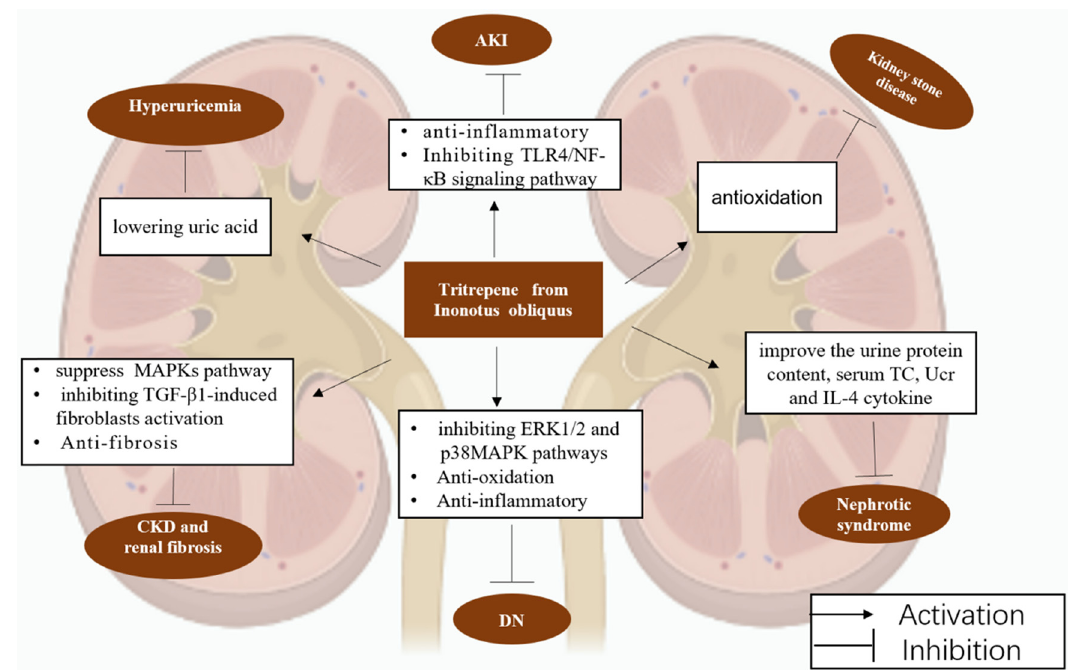
Figure 2: Renoprotective e ff ects of triterpenes from I. obliquus against a broad spectrum of kidney diseases. Triterpene from I. obliquus could prevent kidney diseases by various mechanisms. AKI, acute kidney injury; CKD, chronic kidney disease; DN, diabetic nephropathy; NS, nephrotic syndrome; TC, total cholesterol; UCR, urine creatinine; IL - 4, interleukin -